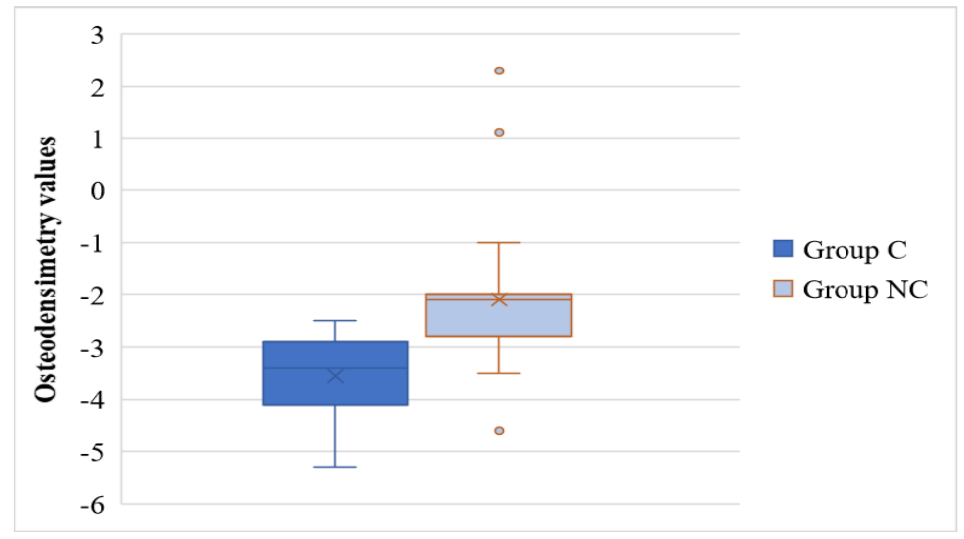
Figure 3. Distribution of T score values in the study groups. C, COVID-19 patients; NC, non-COVID- 19 patients; o, mild outliers. Table 4. SPPB and SARC-F score values of the